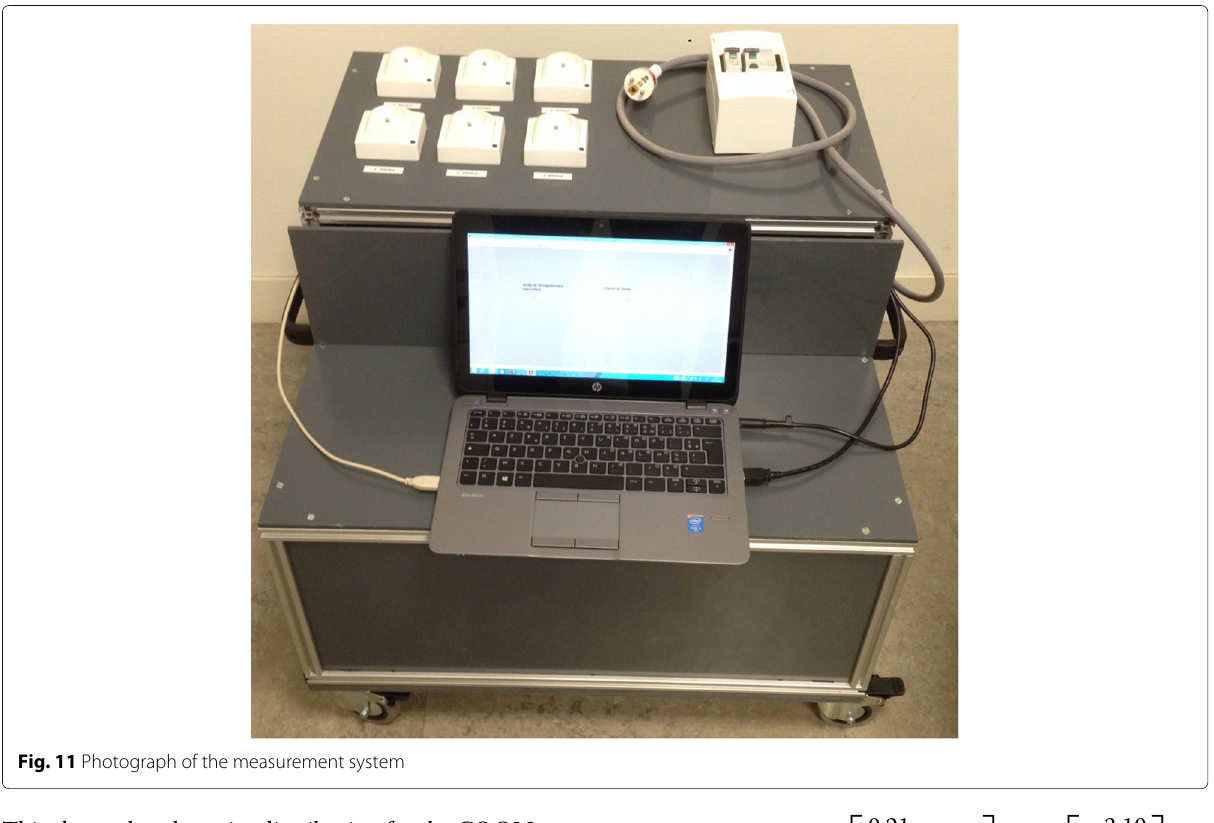
Fig. 11 Photograph of the measurement system